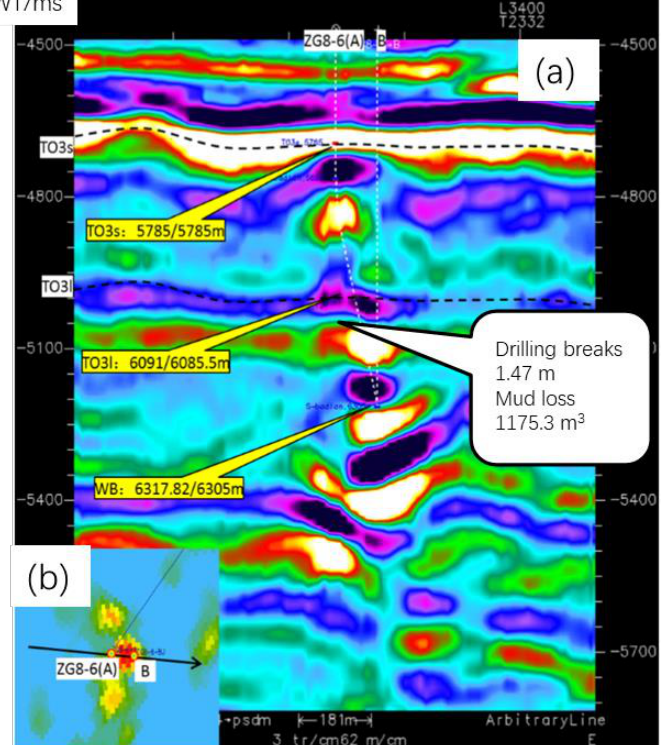
Figure 3. “ Bead shape ” seismic reflection in the seismic profile ( a ) and the strong amplitude in root mean square amplitude attribute ( b ) of the fracture-cave reservoir in Tazhong I Gasfield (large fracture-cave reservoir with caving and large mud loss during drilling; O 3 s: Sangtamu Formation of the Upper Ordovician; O 3 l: Lianglitage Formation of the Upper Ordovician).